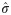
Mathematical models may explain the properties of EFP.(A) In computer simulations, both MUA and EFP showed shorter average response latency and more precise timing than single neurons. The average response latency of single neurons (20 ms, red dash-dot line) itself does not affect the temporal precision of either the MUA or EFP and was chosen arbitrarily for illustrative purposes. (B) In computer simulations, MUAs and EFPs became larger in amplitude and more precise in timing with an increasing number of neurons firing synchronously. With an increasing number of neurons, EFPs showed better temporal precision than MUA for the high-synchrony scenario (left column). Red dashed line shows the predicted effect of the number of firing neurons on the EFP through least squares fitting of the simulation data based on the mathematical models presented in figure panel C (see S1 Text for details). The gof represents the adjusted r-square of least squares fitting. (C) Equation 1 shows that the amplitude of the EFP (L(t)) increases linearly with the number of firing neurons (n). Equation 2 shows that the SD of EFP latency (σ^) is proportional to the SD of single neurons (σ) and decreases with increasing number of neurons (n), following a square root law. (D) Biophysical simulations with 100 neurons firing at varying degrees of synchrony, based on a cell model from Neocortical Microcircuitry [44]. The first peaks of both MUA and EFP had better temporal precision and shorter response latency than the single neurons. Importantly, the EFP was better in temporal precision than the MUA when neurons fired in high synchrony. EFP, extracellular field potential; gof, goodness of fit; MUA, multiunit activity.